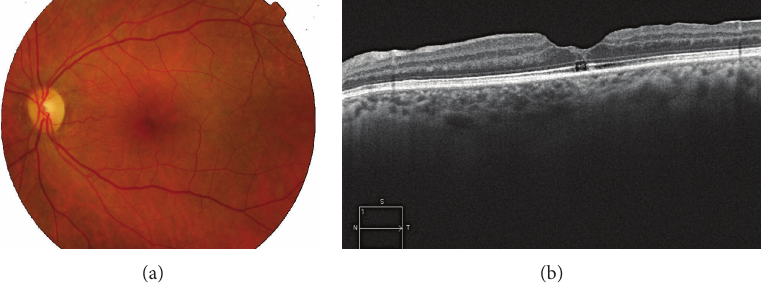
Figure 5: Fundus photography and OCT after reoperation using platelet-derived growth factors. Successful anatomic hole closure is observed but glial type scar in the inner retina and the absence of a continuous ellipsoid band determined a final visual acuity of